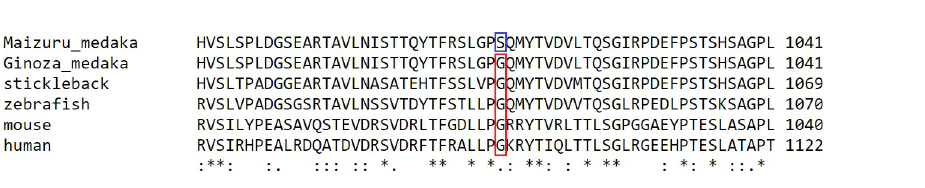
Fig 5. SNED1 protein sequence comparison. Glycine at position 1013 in Ginoza SNED1 (red square) is conserved among other vertebrate species. Serine (blue square) was found only in Maizuru